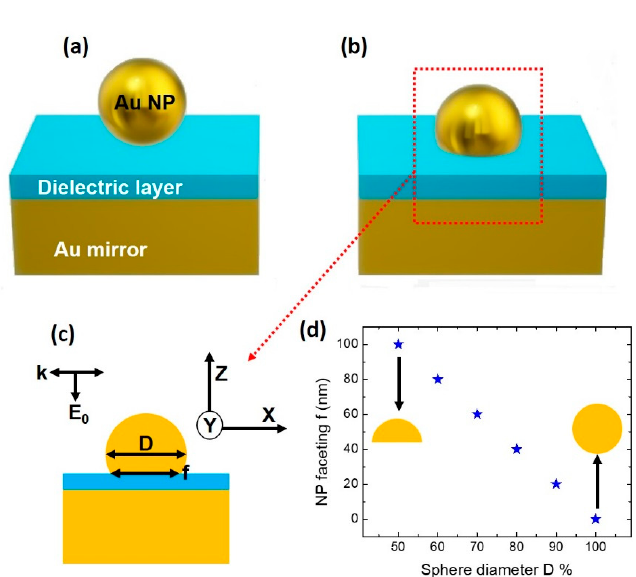
Figure 1. ( a ) Schematic illustration of NP on a metallic mirror (NPOM) structure. Gold was employed as metal, and the dielectric layer was inserted between NP and the metallic film. Faceting parameter influence on NP morphology is shown in ( b ), and an example cross-section view is shown in ( c ). NP diameter changes (%) from a perfect sphere to a hemisphere as a function of the facet “ f ” parameter is shown in ( d ).